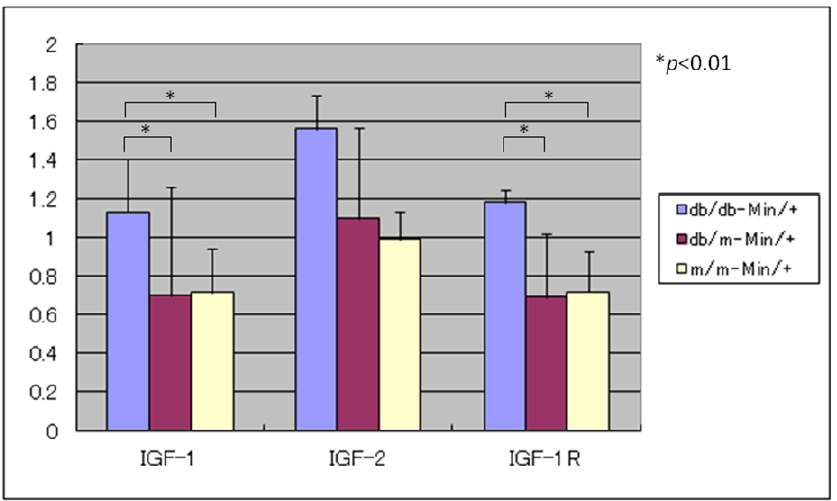
Figure 3. mRNA expression of IGF-1, IGF-2, and IGF-1R in the colonic mucosa of three strains of male mice ( n = 6 from each